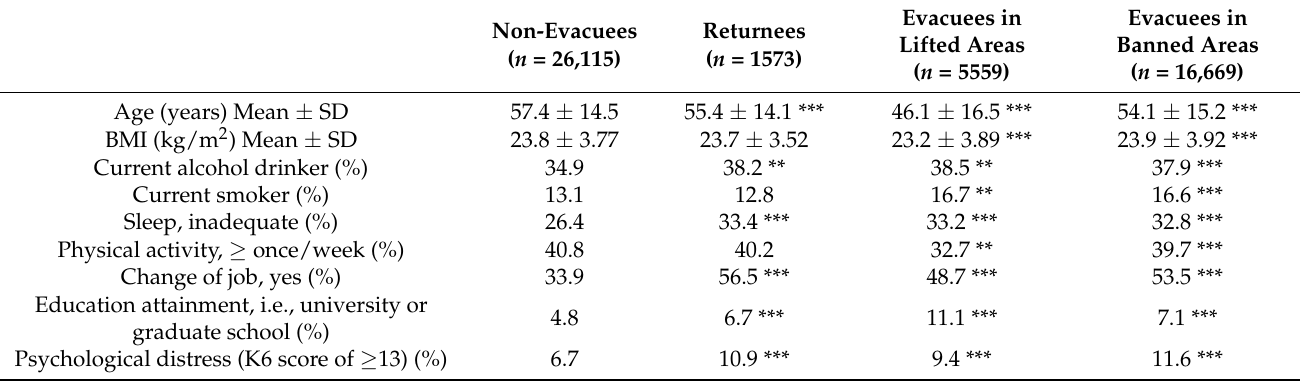
Evacuees in Banned